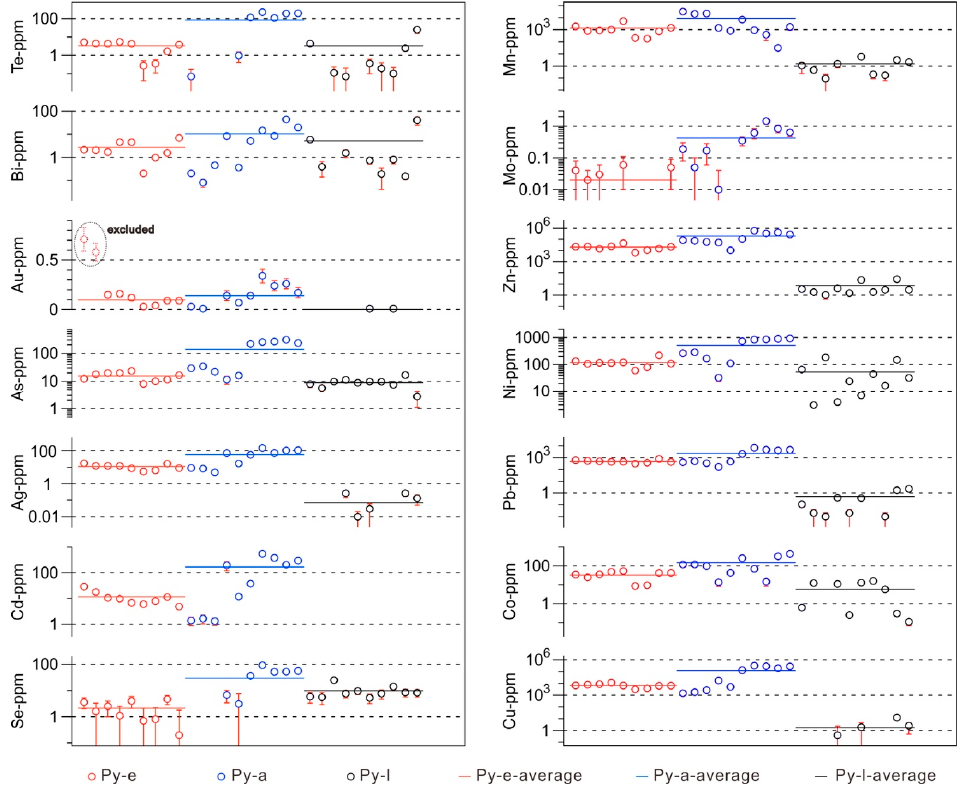
Figure 5. Concentrations of 16 selected elements in the three generations of pyrite using spot analysis mode. Precious metals are more enriched in the sulfide assemblages than Py-e, Py-l is barren of precious metals, but enriched in Se relative to Py-e. We excluded two spots (see diagram for Au) after checking the time-resolved spectra data, where the extremely abnormal peaks in the 197 Au signal are very likely caused by the presence of included native gold.